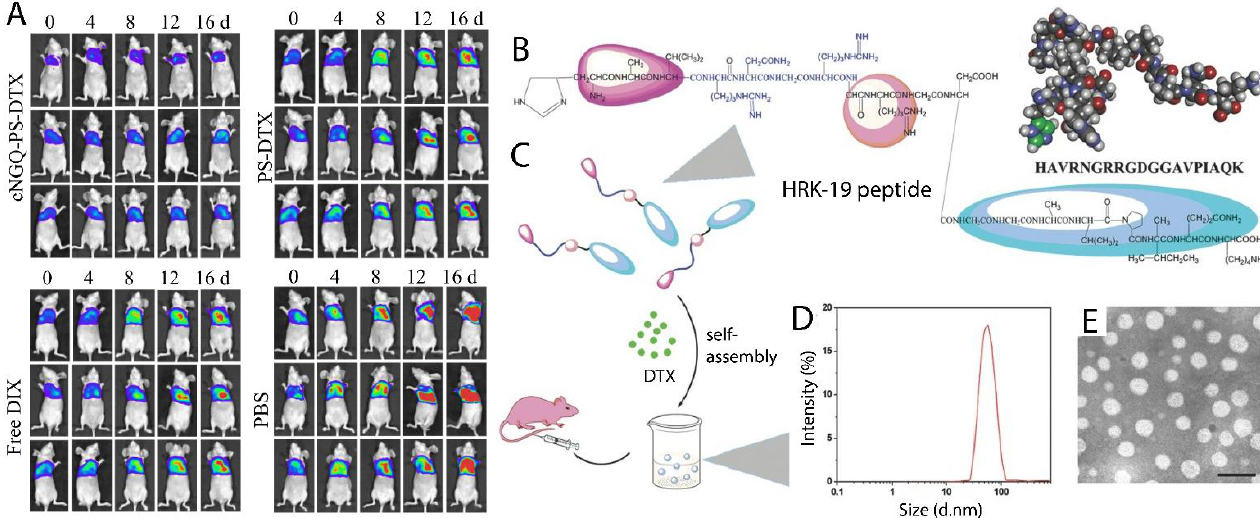
Figure 4. DTX containing NPs against lung cancer. ( A ) Representative bioluminescence imaging of A549 tumor-bearing mice treated with cNGQ-PS-DTX, PS-DTX, free DTX, and PBS. Adapted with permission from [63]. Copyright 2021 American Chemical Society. (B) Schematic and molecular structure of the HRK-19 peptide. ( C ) HRK-19 peptides and DTX mixed to form self-assembled NPs, and then intravenously injected into the tumor-bearing mouse. ( D ) Size distribution graph for DOC/peptide NPs. ( E ) Transmission electron microscope (TEM) image of DOC/peptide NPs (Dulbecco ’ s phosphate-buffered saline (DPBS)). The scale bar indicates 100 nm. [48].